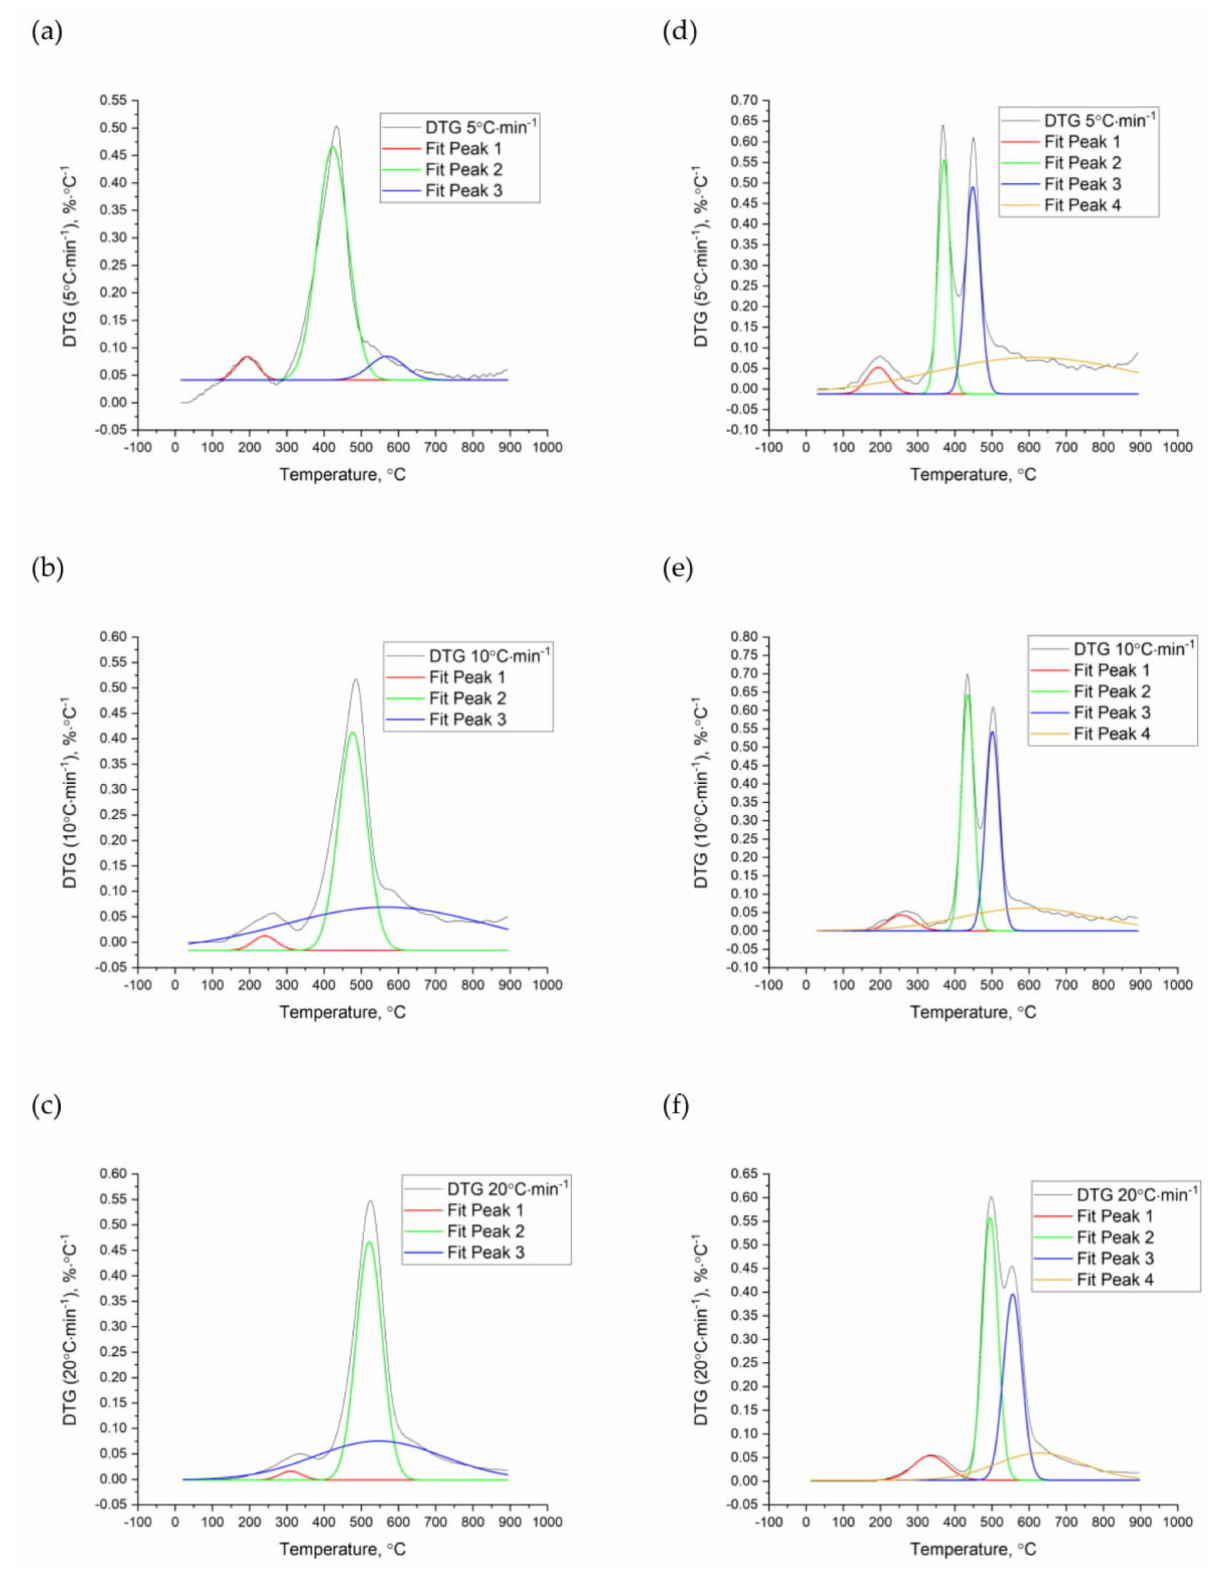
Figure 6. Peaks analysis of the PES ( a – c ) and PIS ( d – f ) pyrolysis process at a heating rate β of 5 ◦ C · min − 1 , 10 ◦ C · min − 1 , and 20 ◦ C · min − 1